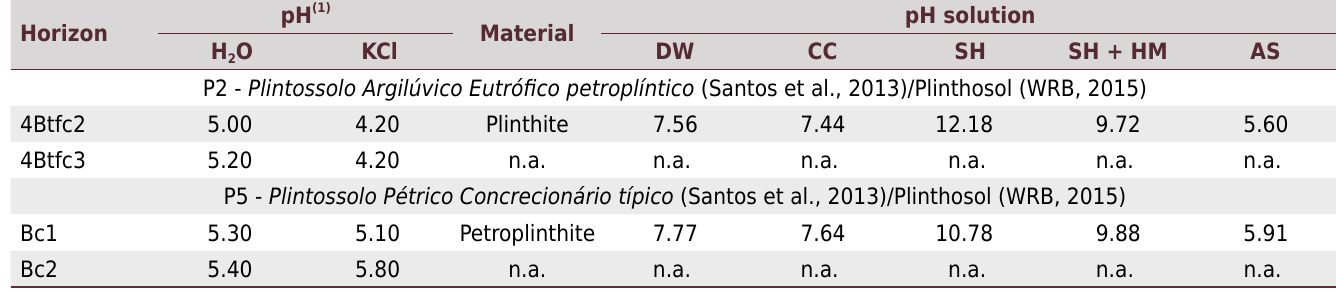
(1) pH(H 2 O) and pH(KCl) at a soil-liquid ratio of 1:2.5. DW = distilled water; CC = calcium carbonate; SH = sodium hydroxide; SH + HM = sodium hydroxide and sodium hexametaphosphate; AS = acid solution; n.a. = not